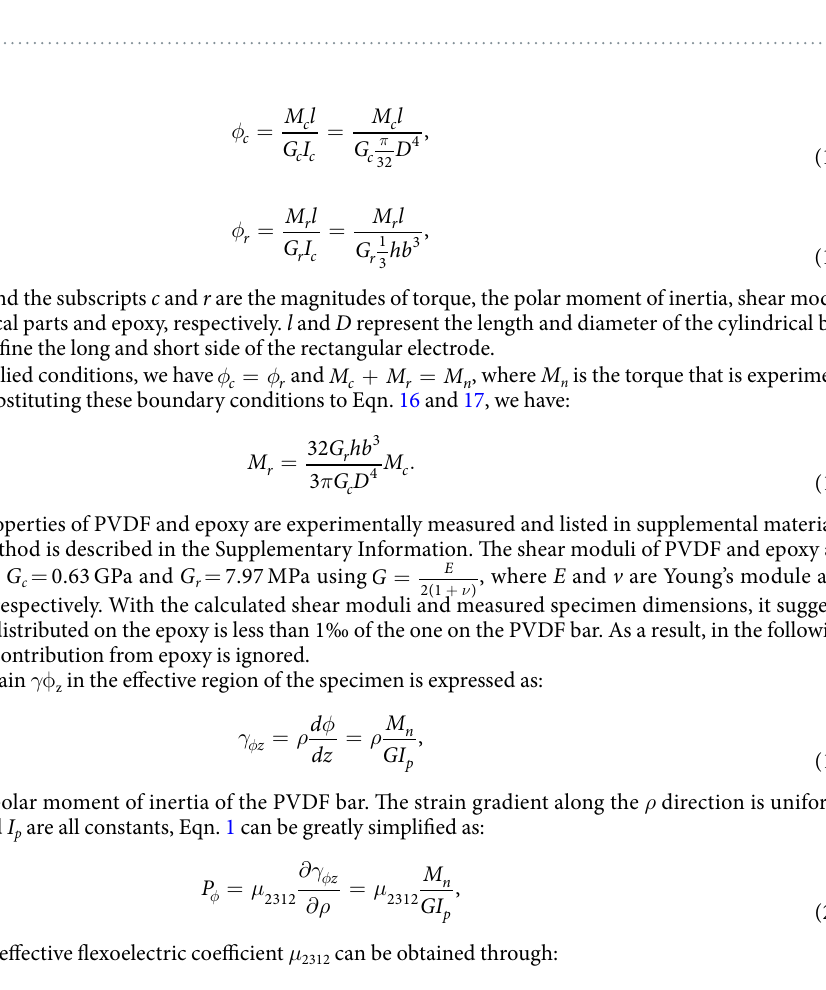
Figure 3. The discussion of the potential residual piezoelectric induced polarization. ( a ) The analysis of the possible impact on the shear stress induced residual piezoelectricity, ( b ) the FEA result of the inhomogeneous compression/tension stress concentration on the specimen, ( c ) the experimental method of the normal stress induced residual piezoelectricity, and ( d ) the sandwich structure of the verification of non-uniformity of strain